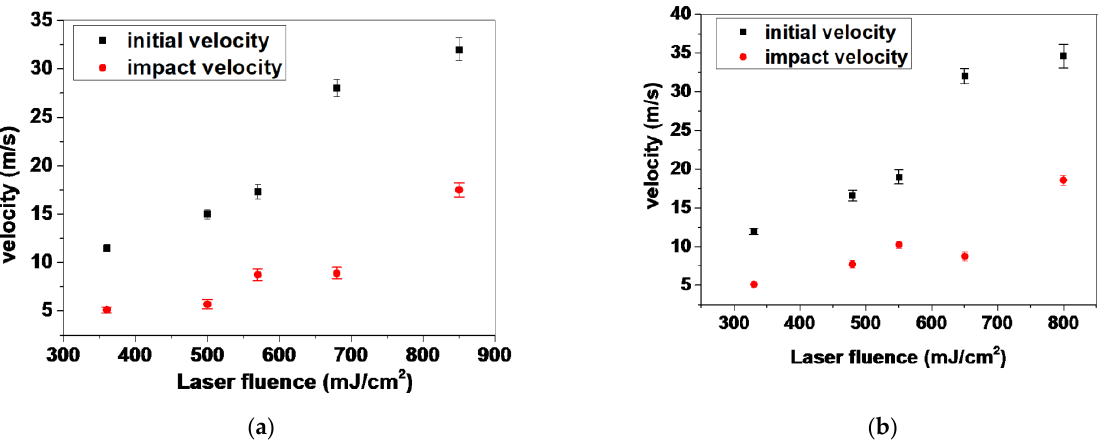
Figure 5. The dependence of produced velocities as a function of laser fluence for both wavelengths. ( a ) at 532 nm and ( b ) at 355 nm for various laser fluences.